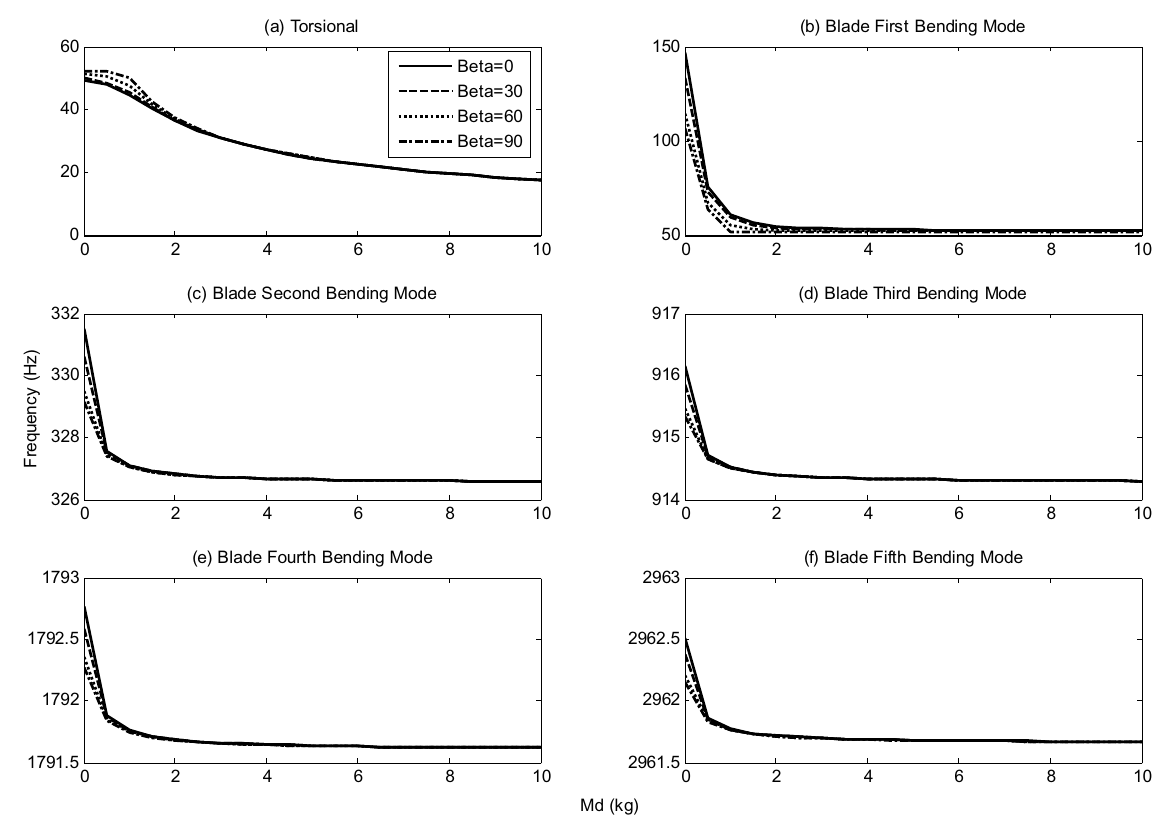
Fig. 6. Natural Frequencies as function of shaft torsional stiffness M D for setting angles: β = 0 ◦ , 30 ◦ , 60 ◦ , 90 ◦ . beam, which are normalized with respect to the mass per unit length of the blade, can be written in the